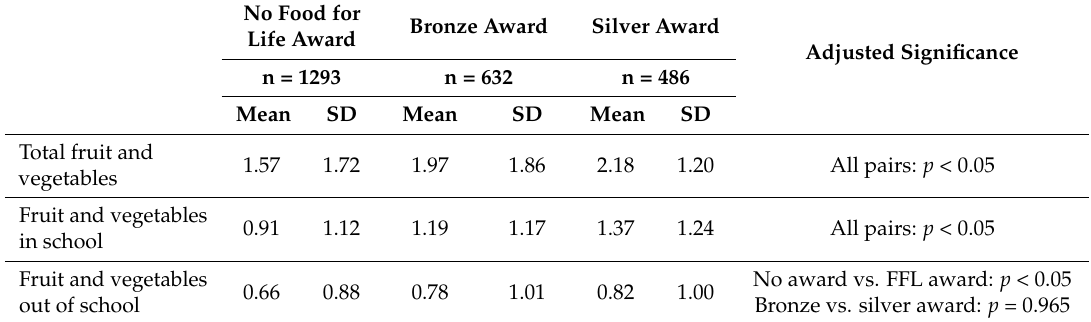
Table 7. Mean number of servings of fruit and/or vegetables consumed by pupils by Food for Life award